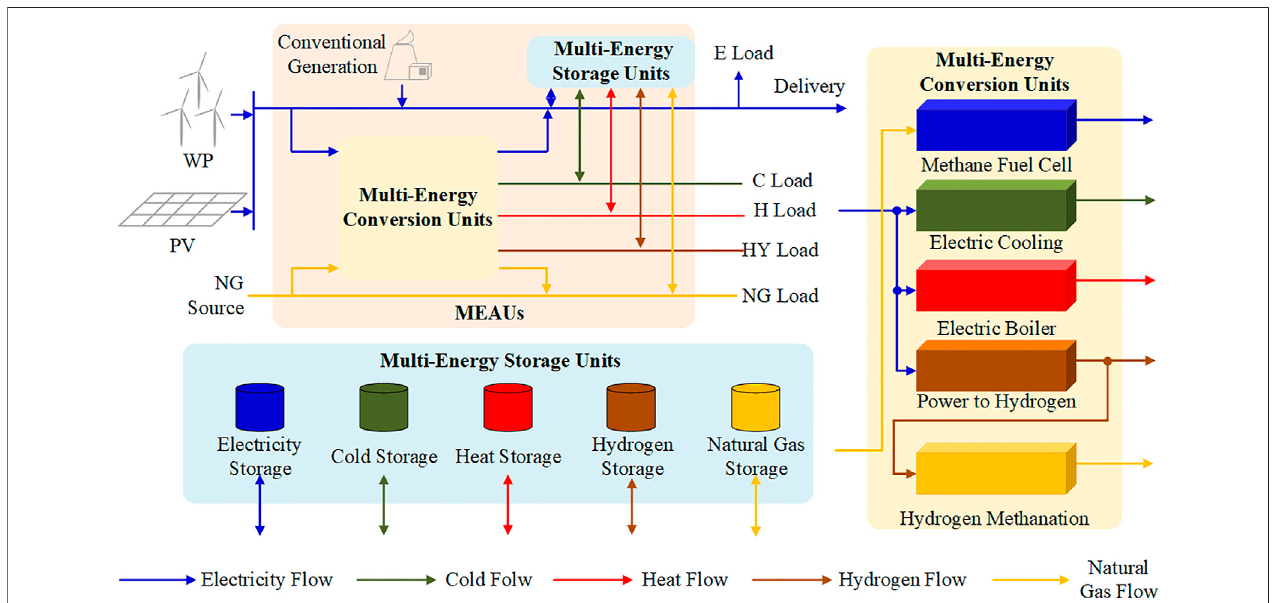
FIGURE 1 | The structure of a grid with high proportion of renewable energy and multi-energy conversion and storage.